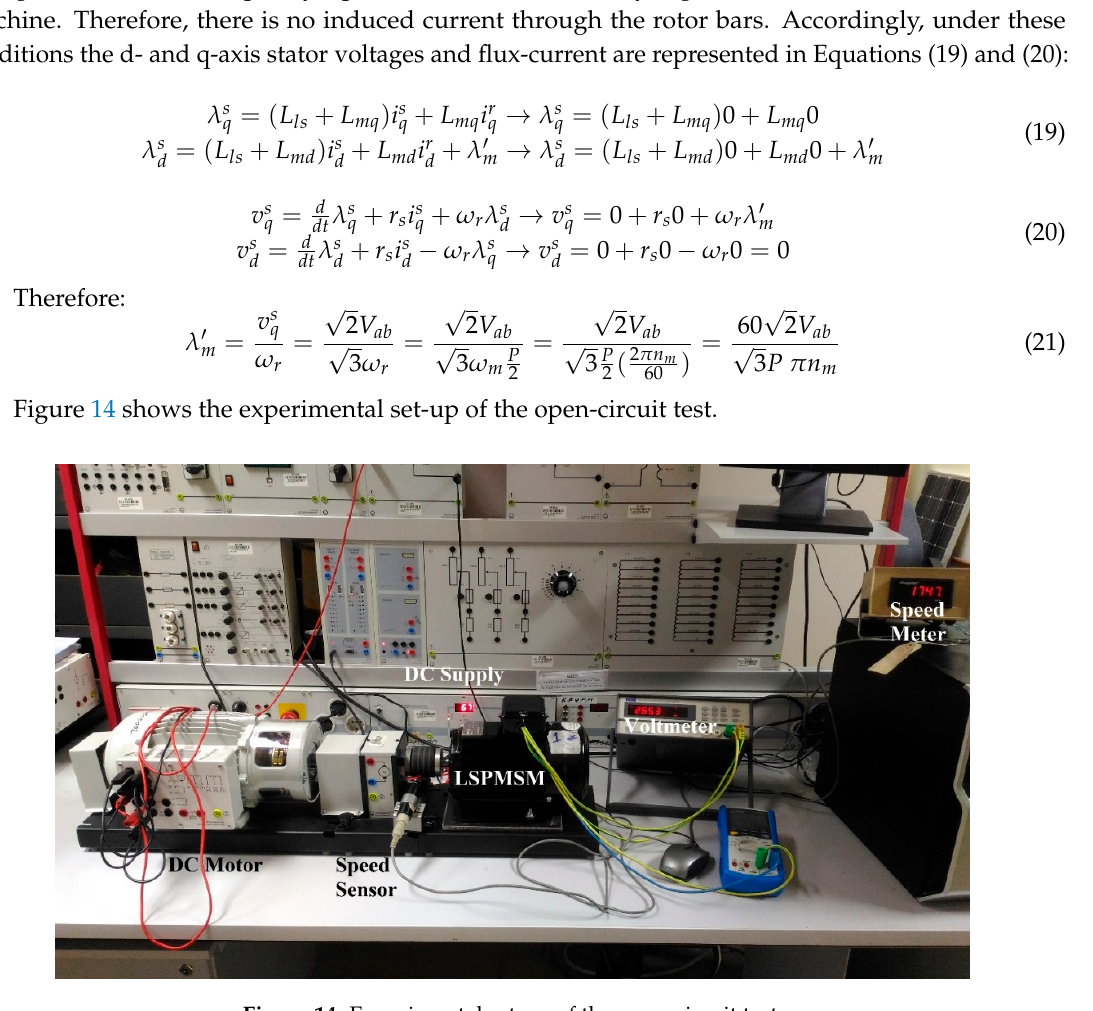
Figure 13. Open-circuit test diagram.